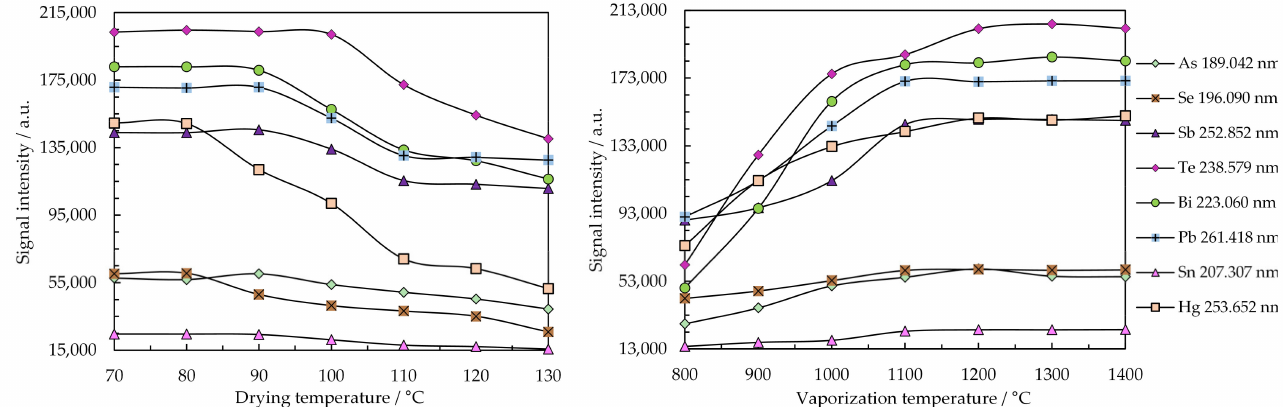
Figure 4. Influence of the drying ( a ) and vaporization ( b ) temperatures on the emission of the most sensitive lines of As, Bi, Sb, Se, Te, Hg, Pb, and Sn registered with the Maya2000 Pro microspectrometer. Conditions: plasma power: 15 W; Ar flow rate: 150 mL min − 1 ; observation height: 0.8 mm above the electrode tip; sample: 10 µ L containing 3 µ g mL − 1 As, Bi, Se, Te, and Sn; 1 µ g mL − 1 Pb and Sb; and 0.2 µ g mL − 1